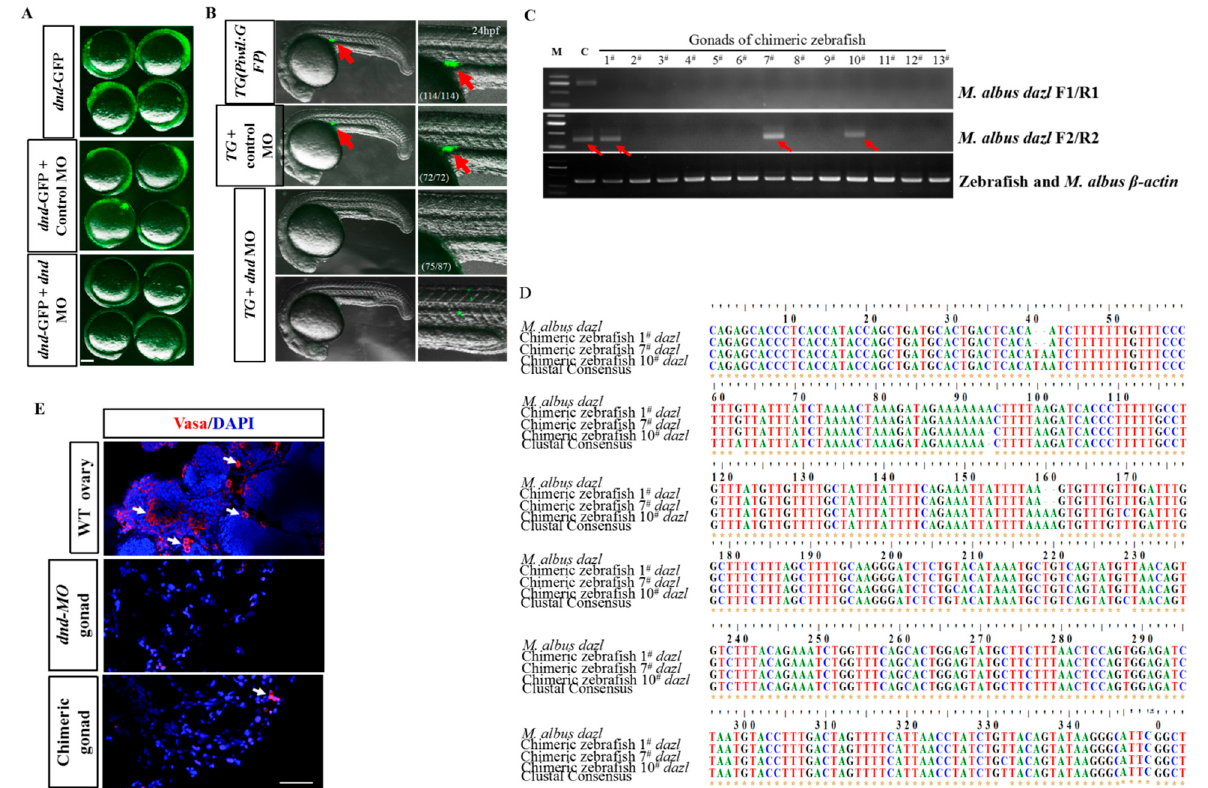
Figure 5. GSCs contribute to the germline cell lineage of host embryos to generate zebrafish germline chimeras. ( A ) The dnd MO abolished the expression of dnd-GFP reporter, whereas the control MO did not. ( B ) Images showing GFP signals in embryos injected with control and dnd MOs. The GFP-positive PGCs (red arrows) were distributed in the gonadal region of the Tg( piwil1:eGFP ) embryos or embryos injected with control MO. No GFP-positive PGCs were observed in the gonadal region of embryos injected with dnd MO. The frequency of embryos with the indicated phenotypes was shown in the bracket of each group. Lateral view. Scale bars, 500 µ m. ( C ) Gel images of RT-PCR products showing the expression of the eel-specific dazl gene in gonads of transplanted zebrafish. β -actin was used as a reference gene. Red arrows indicate PCR bands amplified by second-round RT-PCR. ( D ) Alignment of the amplified dazl sequences from gonads of M. albus and gonads of three fGSCs-transplanted zebrafish. ( E ) IF staining of Vasa in ovaries of control-, dnd MO-, and dnd MO-transplanted with fGSCs zebrafish. White arrows indicate the germ cells. Scale bar = 50 µ